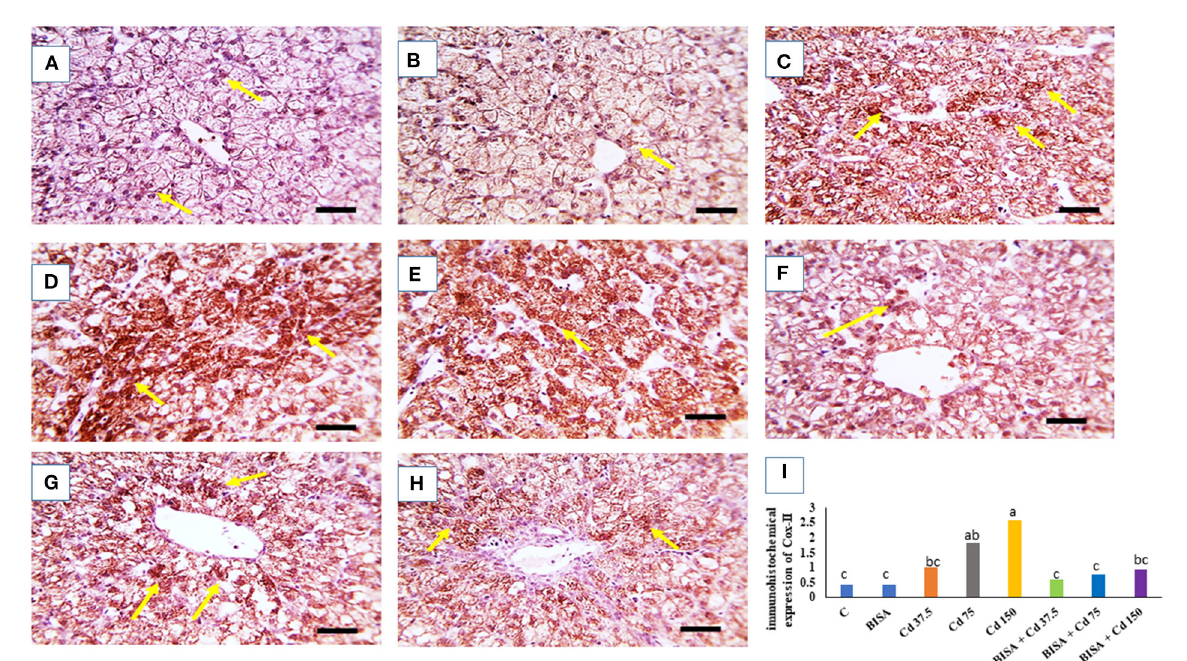
FIGURE5 Quantitative data of COX-2 immunohistochemical staining intensity in the duck liver. (A) Expresses the control group (C) and (B) represents the bisabolol (BISA) alone group; both panels show very mild COX-2 brown staining in hepatocytes. (C–E) Are for groups receiving CdCl 2 at 37.5, 75, and 150 mg/kg diet, respectively, showing a dose-dependent increase in the brown staining. (F–H) Represent BISA + Cd 37.5, BISA + Cd 75, and BISA + Cd 15 groups, respectively, and display a marked decline of COX-2-staining, compared to the corresponding CdCl 2 alone groups. (I) Shows the quantitative data of COX-2 staining in hepatic tissues for the experimental groups. Quantitative data are expressed as mean ± SEM ( n = 6). Bars carrying different letters are significantly different from one another ( p < 0.05). The Image J software (National Institutes of